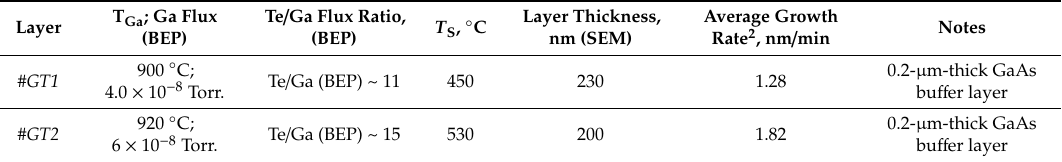
Table 2. The growth parameters of GaTe / GaAs (001)